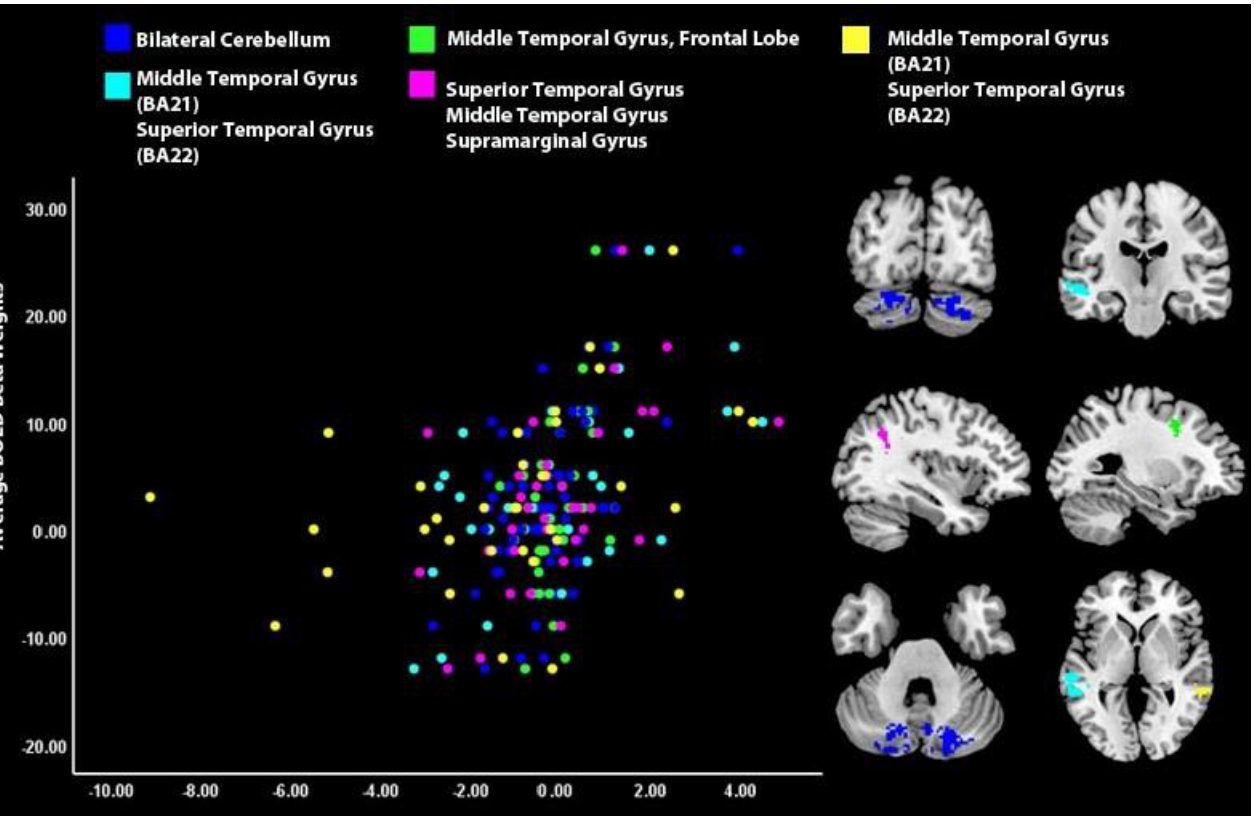
Figure 3. Brain activity during self-processing associated with symptom change in depressed youth, n = 34: Changes in activity during ESOM-Q Post vs. ESOM-Q Pre were associated with change in depression score.